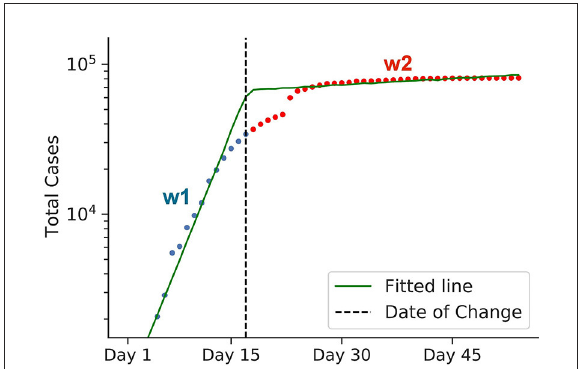
FIGURE4 Graphical representation of estimating policy strength. The green line represents a log-scaled cumulative case counts. Due to some interventions, the graph bends at the change-point, as indicated by the black dotted line. The change-point divides the graph into two intervals: blue and red. Both lines have different slopes, w 1 and w 2 , respectively, which represent the virus transmission rates before and after the intervention came into effect. To calculate the efficiency of the intervention, we use the formula 1 − w 2 / w 1 . The data for early Chinese cases was used for this example. Here, the calculated 1 − w 2 / w 1 value represents the efficiency of the lockdown policy of China back